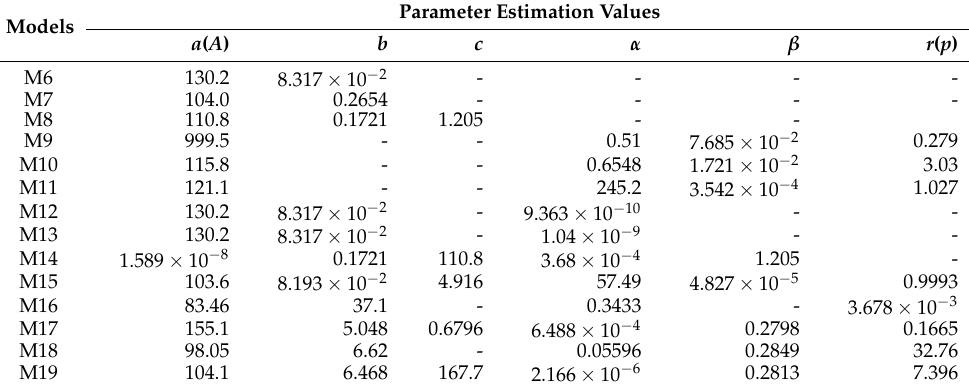
Table 4. Parameter estimates of M6 to M19 for DS-2.